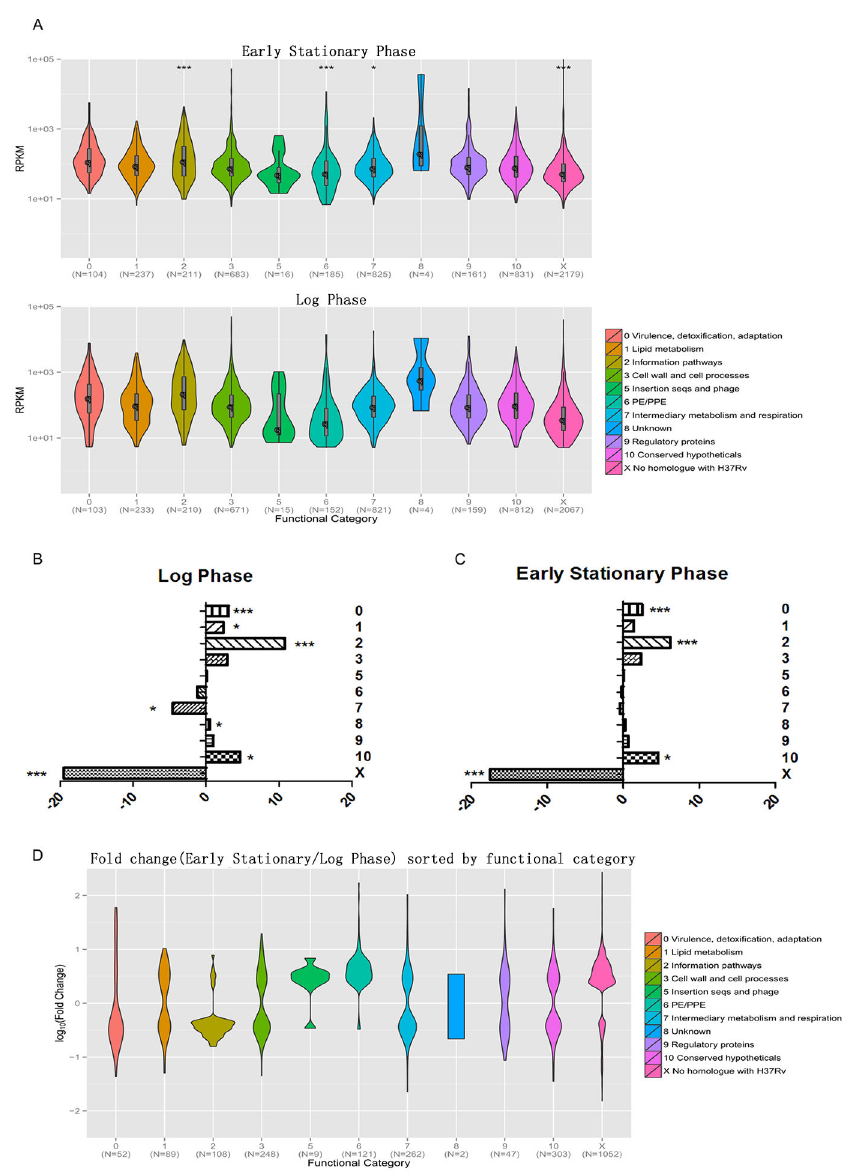
Figure 2. Representation of functional categories in log- and early stationary phase transcriptome. (A) Genes of M.m were grouped according to their homologs in M.tb . Numbers on the x-axis indicates 11 categories and gene numbers contained in each category. Numbers on the y-axis represents RPKM values. RPKM values of each category were analyzed between two samples using Wilcoxon test. * p<0.05, *** p<0.001. (B and C) Values on the x-axis indicate the difference in percentage; positive values indicate over-representation of a particular category compared to the percentage observed in the annotated genome whereas negative values represent under-representation. (B) Difference in percentage of selected categories of top 10% log phase transcripts (n=525, Fisher’s exact test). (C) Difference in percentage of selected categories of top 10% early stationary phase transcripts (n=544, Fisher’s exact test). (D) Genes with significant changes (fold change>2, q value<0.001) were grouped.